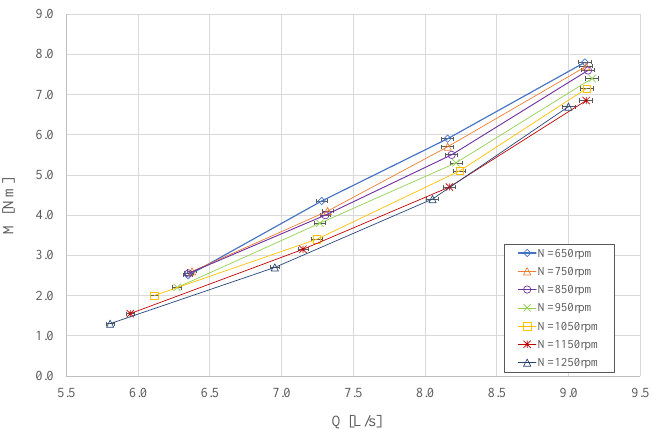
Figure 7. Curves of torque vs. flow rate through the PAT, each referring to a specific rotational speed of the PAT.